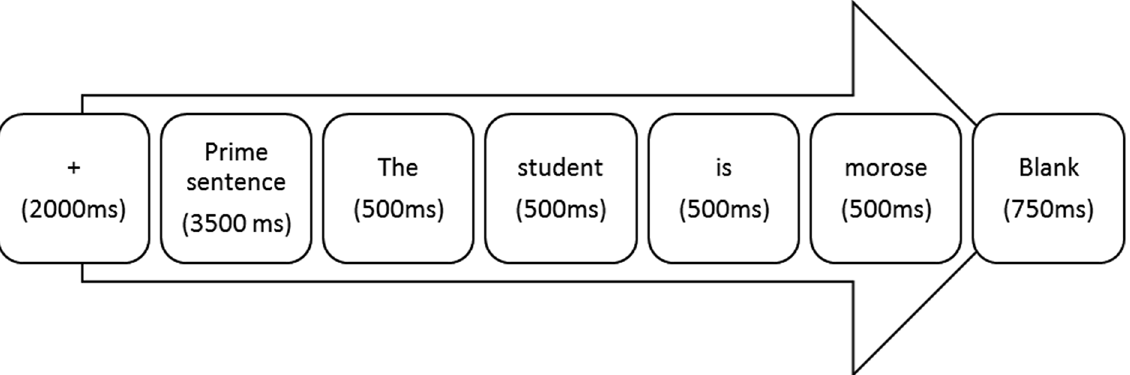
Fig 1. Trial procedure. Each trial had the following structure: a fixation point was presented in the center of the screen (2000 ms), followed by a context sentence (3500 ms) and a target sentence, with each word being presented sequentially (500 ms for each word). Each trial was followed by a black screen which was displayed for 750